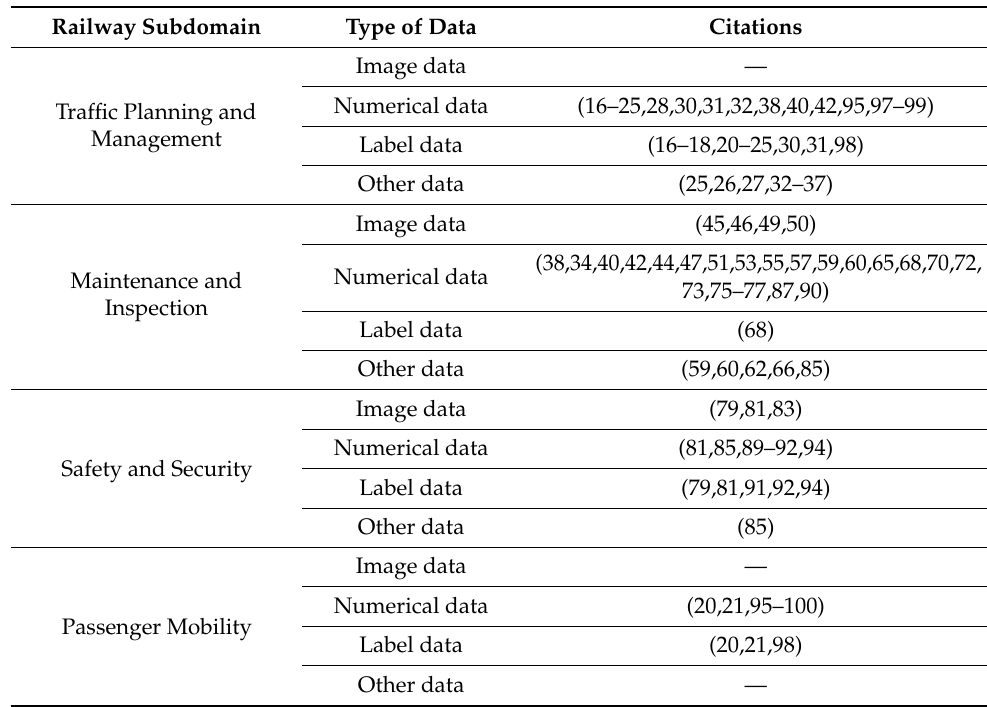
Table 3. Reviewed datasets divided according to railway subdomain and data